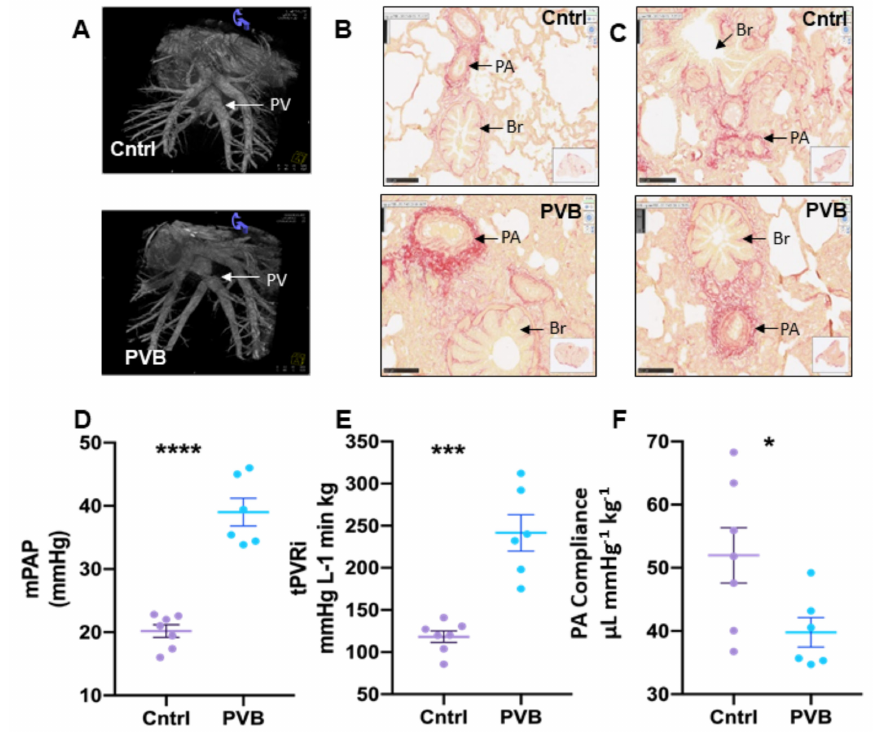
Figure 1. Pulmonary vein banding causes PH. ( A ) Angiogram of the inferior venous confluence of a representative Cntrl (top) and PVB animal (bottom). ( B , C ) Picrosirius red staining of the lung upper and lower lobe in Cntrl and PVB animals. ( D – F ) Mean pulmonary artery pressure (mPAP), total pulmonary vascular resistance index (tPVRi) and pulmonary artery compliance in awake, resting swine. PA—pulmonary artery, PV—pulmonary vein, Br—bronchiole. Values are means ± SEM. * p ≤ 0.05, *** ≤ 0.001, **** ≤ 0.0001. Scale bar: 100 µ m. PVB vs. Cntrl by Student’s t -test, Cntrl n = 7; PVB n =